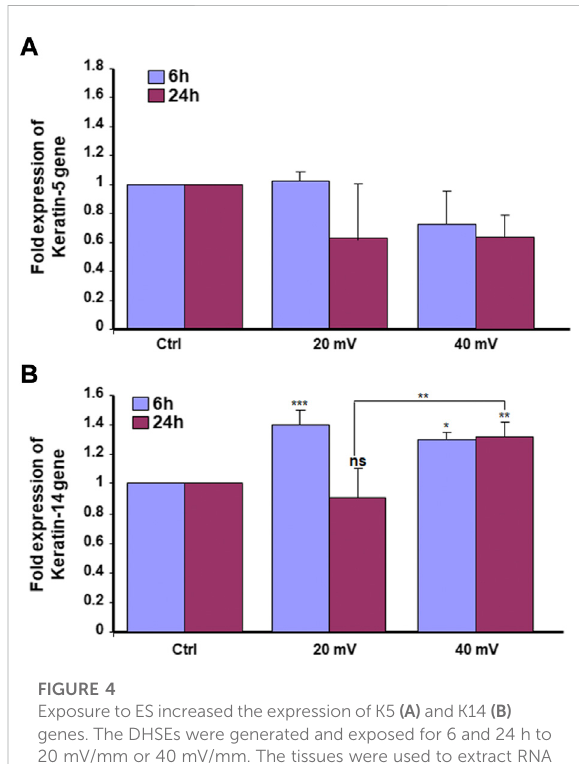
Exposure to ES increased the expression of K5 (A) and K14 (B) genes. The DHSEs were generated and exposed for 6 and 24 h to 20 mV/mm or 40 mV/mm. The tissues were used to extract RNA and perform qRT-PCR to evaluate the expression levels of K5 and K14. Results are presented as a fold expression of the gene in the test sample compared to this gene expression in control. Data are expressed as means ± SD from triplicate assays of three different experiments. (ns), non-signi fi cant. * p ˂ 0.05, ** p ˂ 0.01. Free asterisks refer to the statistical difference when comparing the ES-exposed and nonexposed (Ctrl) tissues. Bars with asterisks show the comparison of the different intensities of